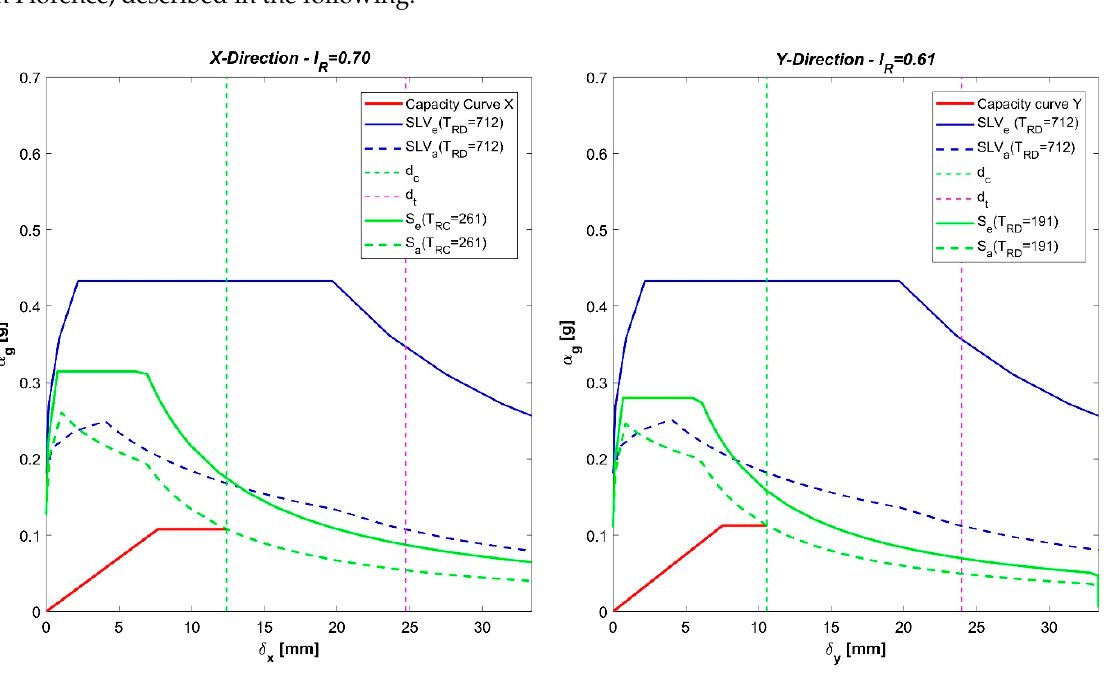
Figure 1. Final output of the pushover analysis, verification in the acceleration-displacement response spectra (ADRS) plane.